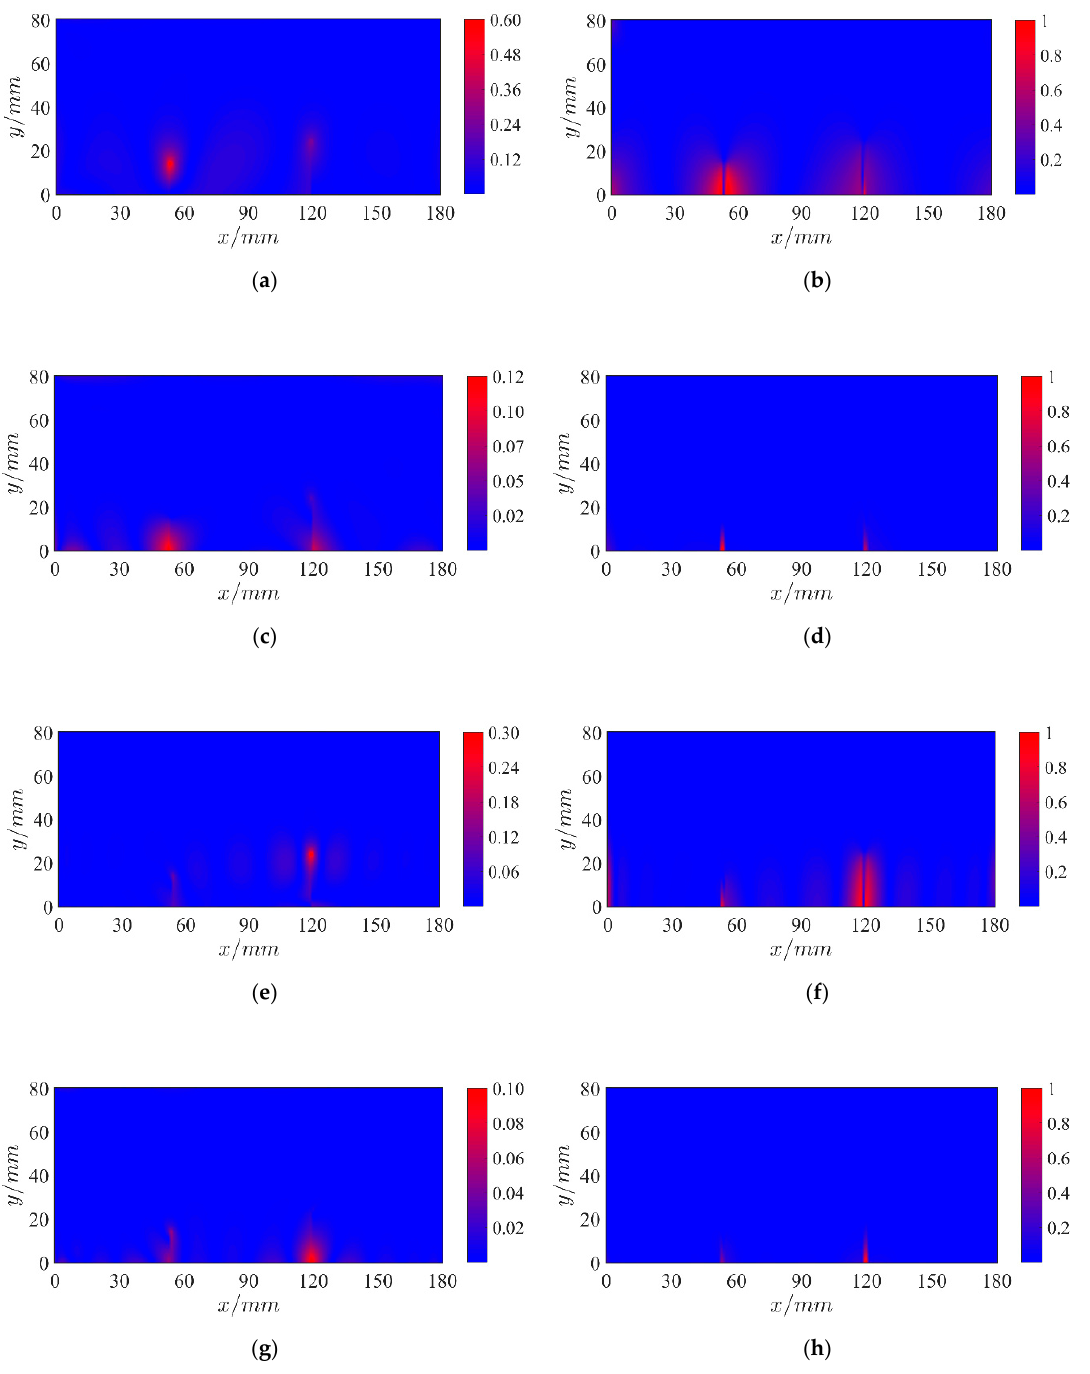
Figure 5. The rotational damage indicators (RDIs) colored plot of the first four modes. ( a ) RDIs of the first mode of the x direction. ( b ) RDIs of the first mode of the y direction. ( c ) RDIs of the second mode of the x direction. ( d ) RDIs of the second mode of the y direction. ( e ) RDIs of the third mode of the x direction. ( f ) RDIs of the third mode of the y direction. ( g ) RDIs of the fourth mode of the x direction. ( h ) RDIs of the fourth mode of the y direction.